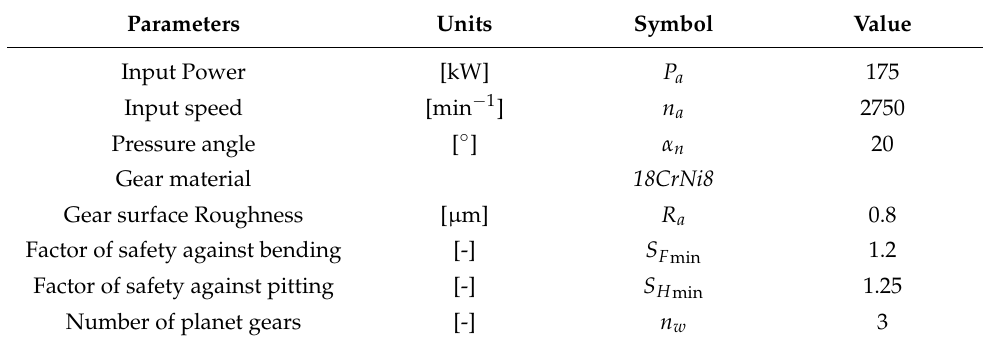
Table 1. Parameters of the planetary gearbox considered in the